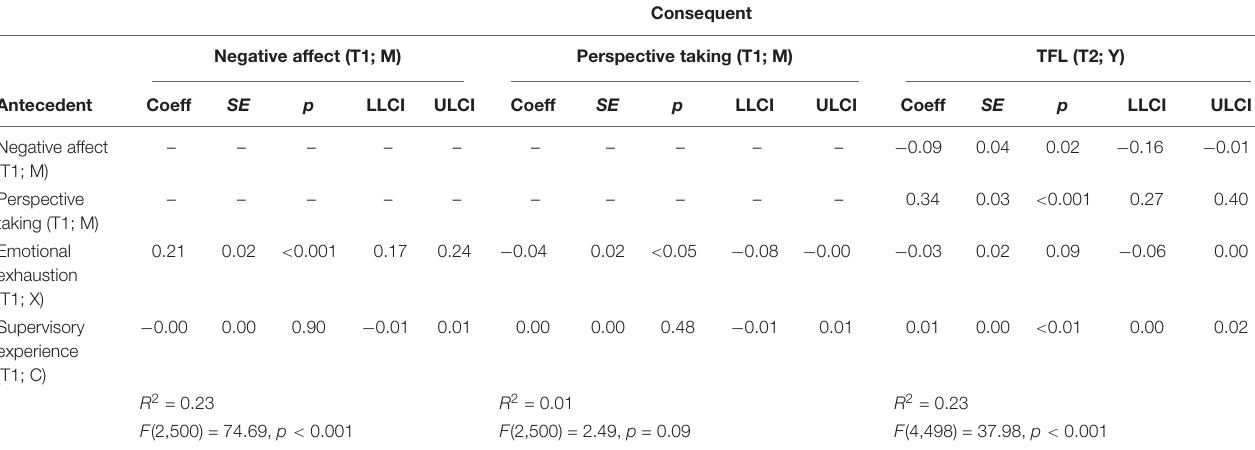
TABLE 2 | Direct and indirect effects model coefficients for effects of emotional exhaustion on transformational leadership (TFL).